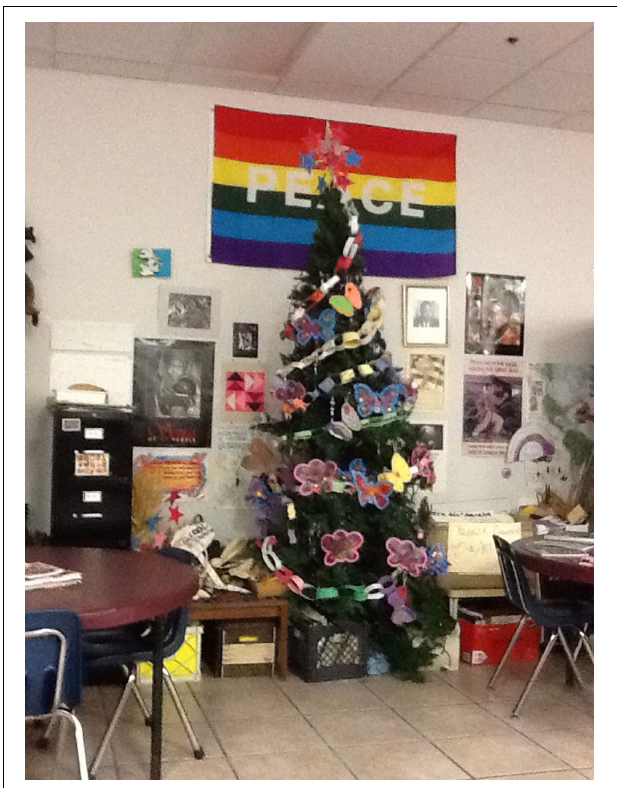
FIGURE 8 | Cancer race commemorative